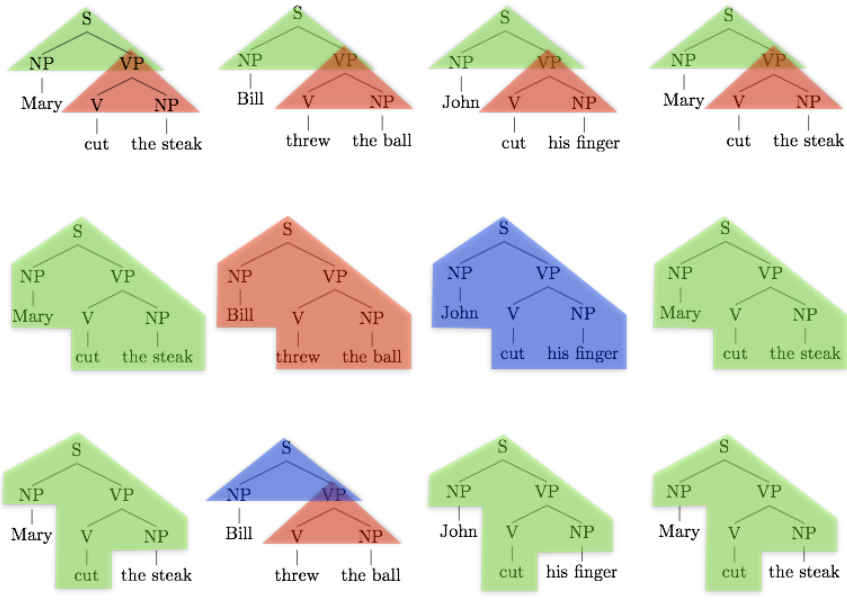
Figure 3: Inference in the argument-only model